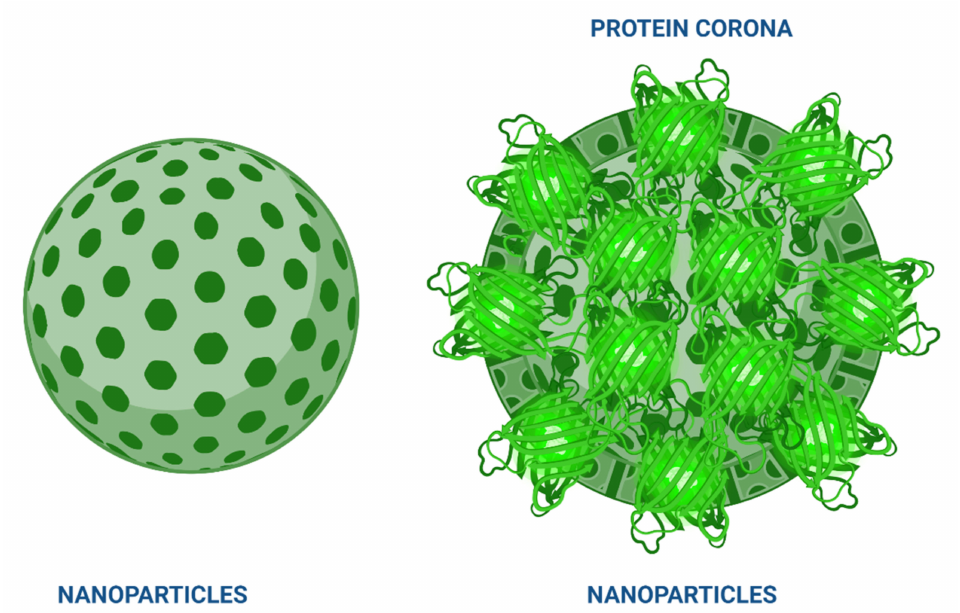
Figure 3. Protein corona formation on the surface of NPs. The corona effect occurs when nanoparticles enter the physiological environment. Protein corona and nanoparticles interact, and the adsorption of some proteins produces innate immune reactions such as complement activation and